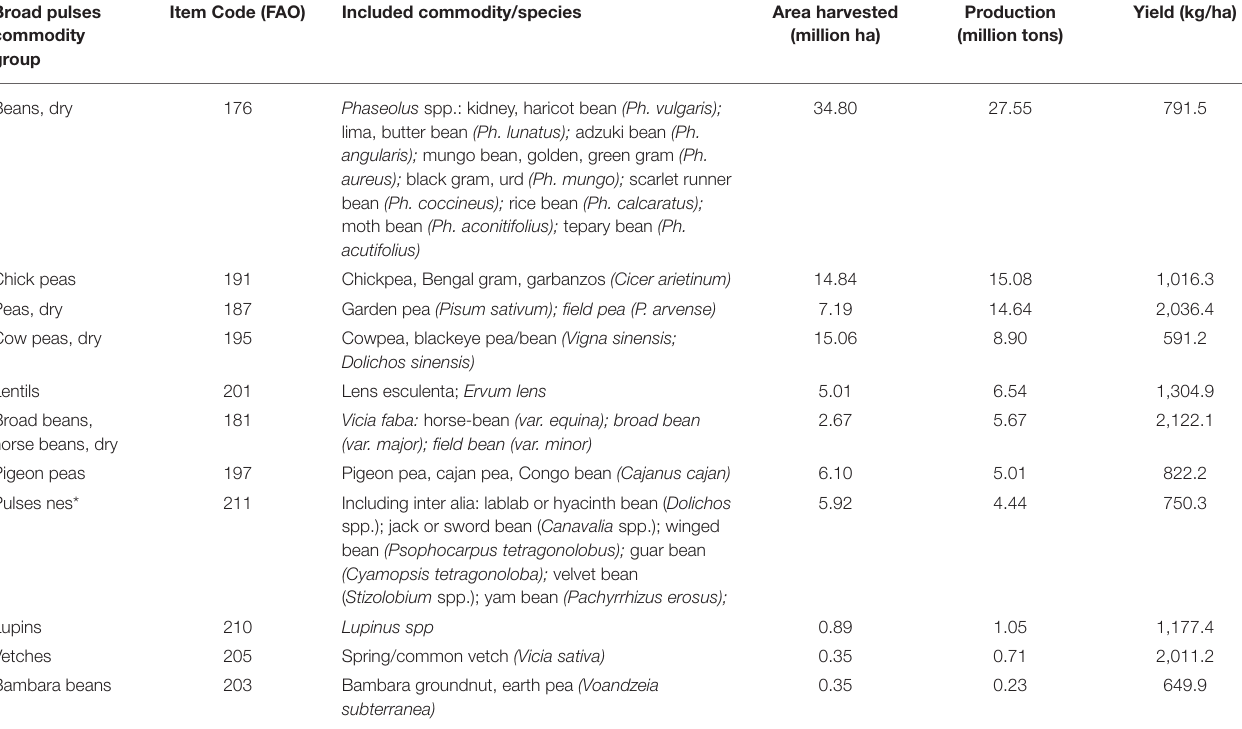
TABLE 1 | Area, production, and productivity of major pulses. Broad pulses